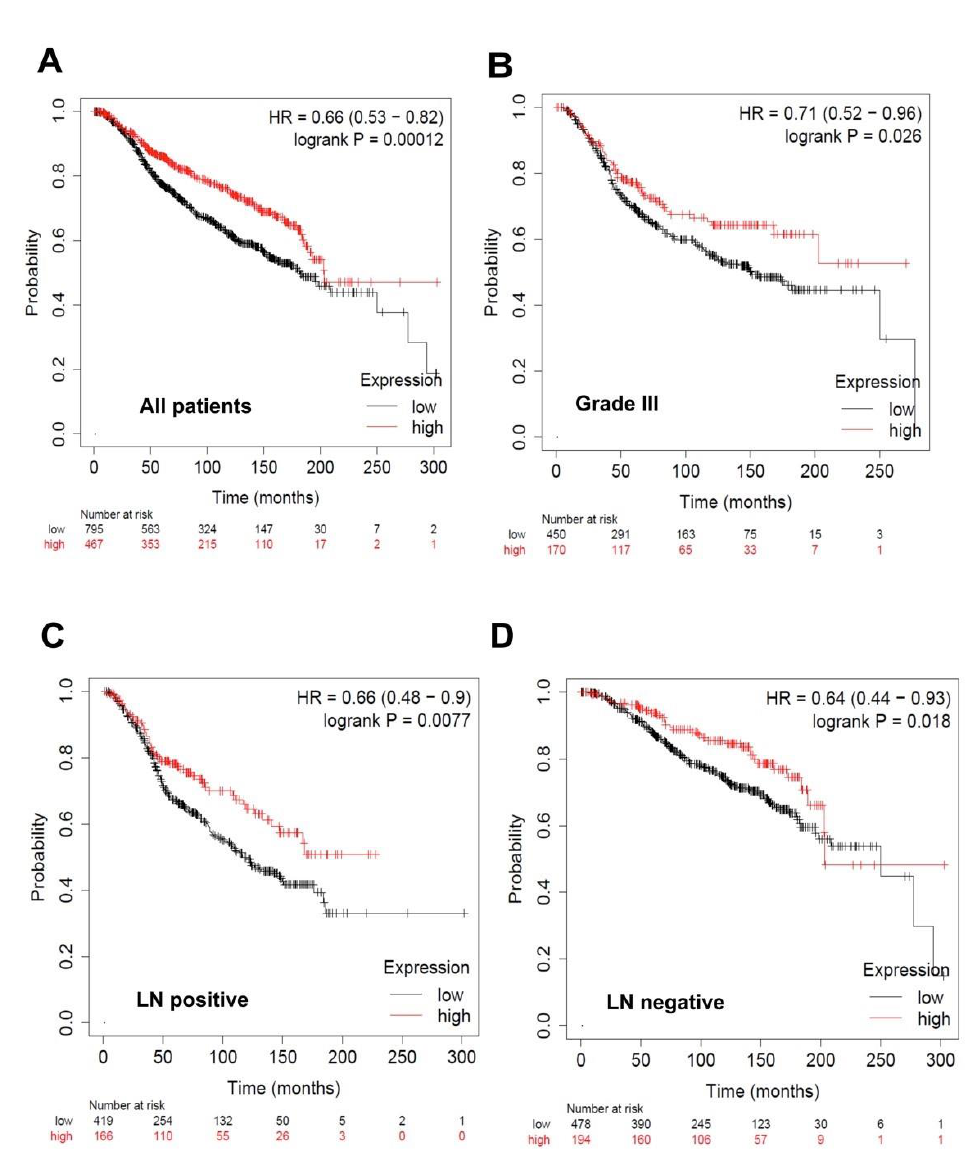
Figure 9. Overall survival curves according to miR-1 expression in breast cancer patients. Low miR-1 expression correlated with worse outcome. Kaplan-Meier curves are plotted for the expression of miR-1 in ( A ) all patients ( n = 1262), ( B ) patients with grade III ( n = 620), ( C ) LN-positive patients ( n = 585), and ( D ) LN-negative ( n = 672). Curves were analyzed using the log-rank test. Log-rank p values and hazard ratios are shown.